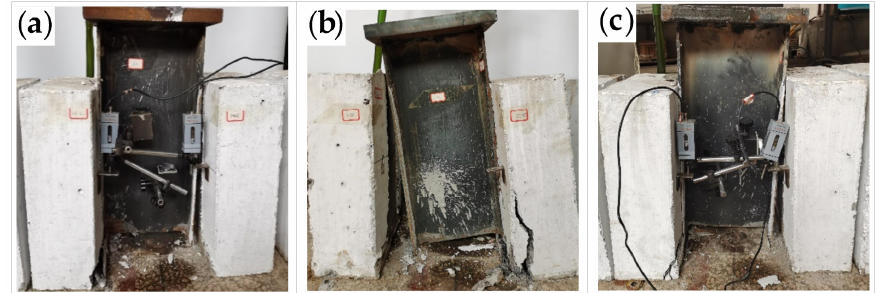
Figure 7. Shear fracture of studs in the concrete slab on one side of the specimen: ( a ) specimen F-1; ( b ) specimen F-4; ( c ) specimen F-5.